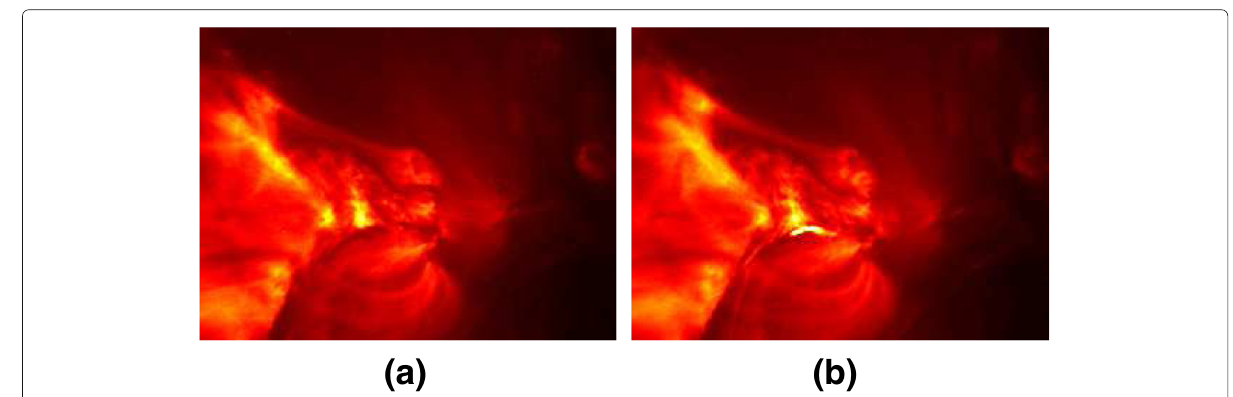
Fig. 10 Snapshot of the original solar flare data ( a ) at t = 150; ( b ) at t = 223. The true change-point location is at t =